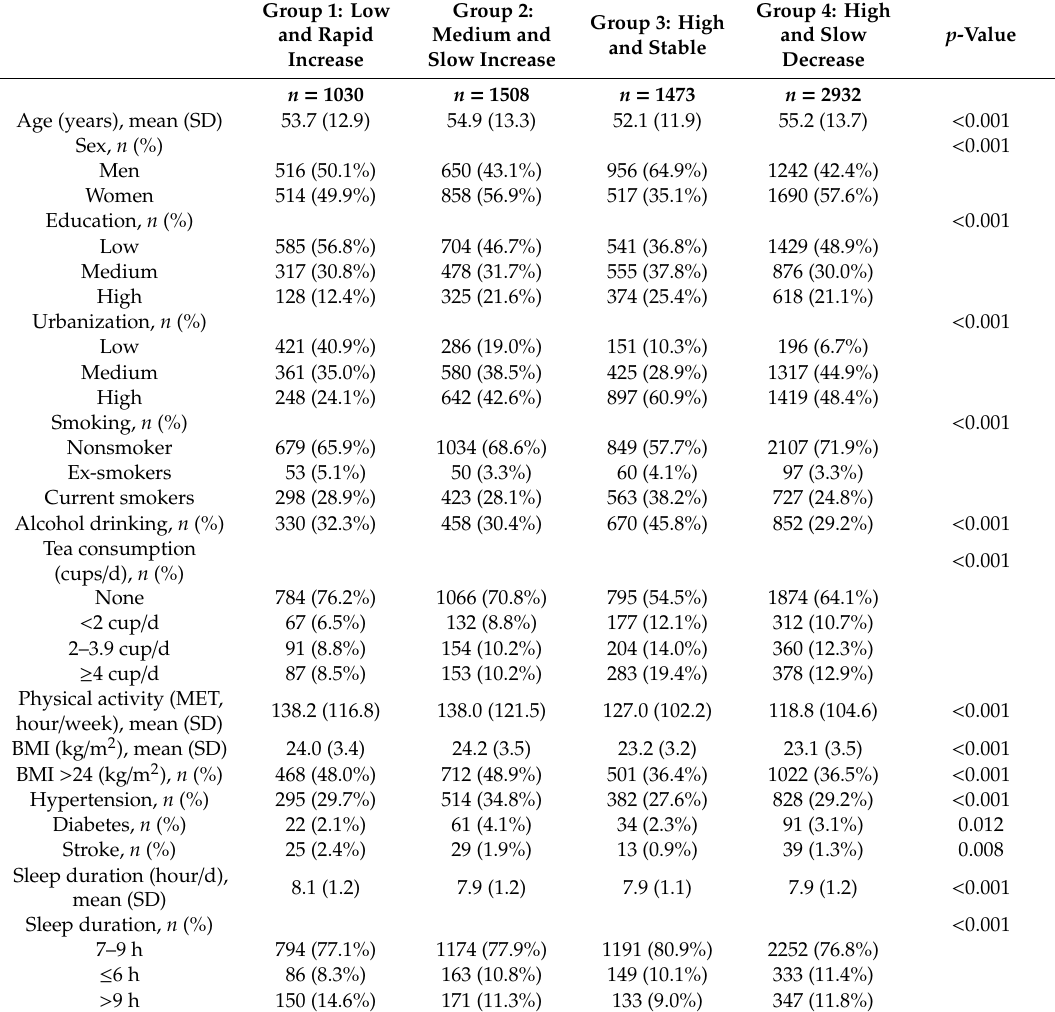
Table 1. Sample characteristics by trajectories of the traditional dietary pattern in 2009 ( n = 6943) *